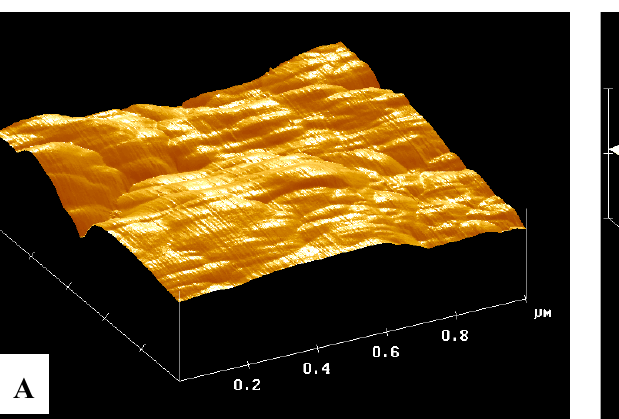
mineral. ( A ) surface at full scale of 1 µm; ( B ) same surface after the absorption of 150 µL of solvent; ( C ) same surface after the absorption of 150 µL of surfactant solution; ( D ) false color image of xy plane of same zeolite